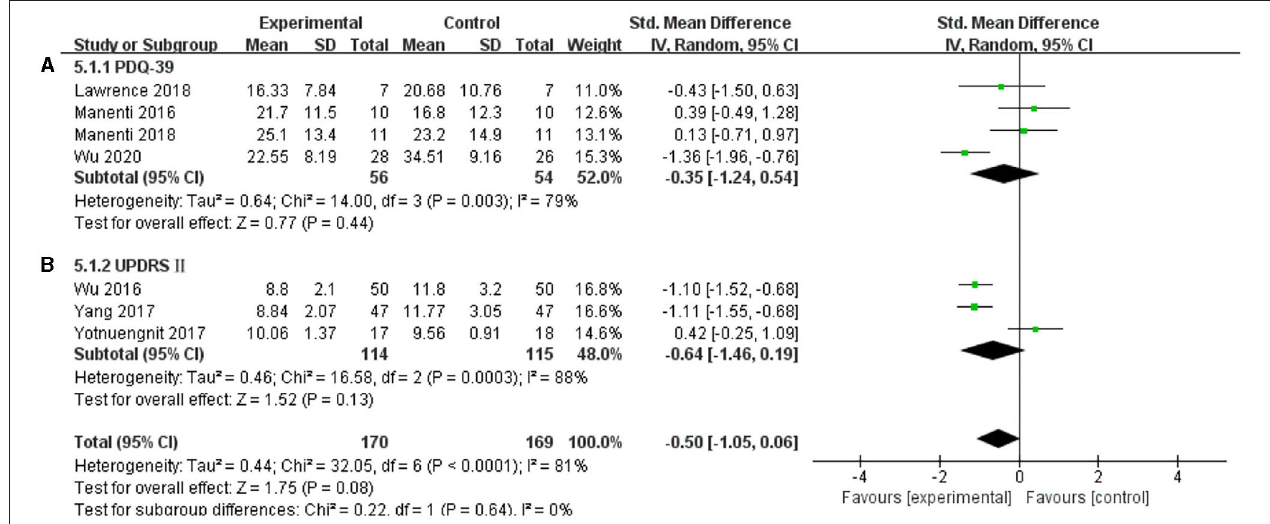
FIGURE 10 | Effects of tDCS on the daily living scores of patients with PD. As shown in (A,B) , tDCS did not significantly improve the ability of daily living of patients with PD. CI, confidence intervals; PD, Parkinson’s disease; PDQ-39, Parkinson’s Disease Quality of Life Questionnaire-39; SD, standard deviation; UPDRS, Unified Parkinson’s Disease Rating